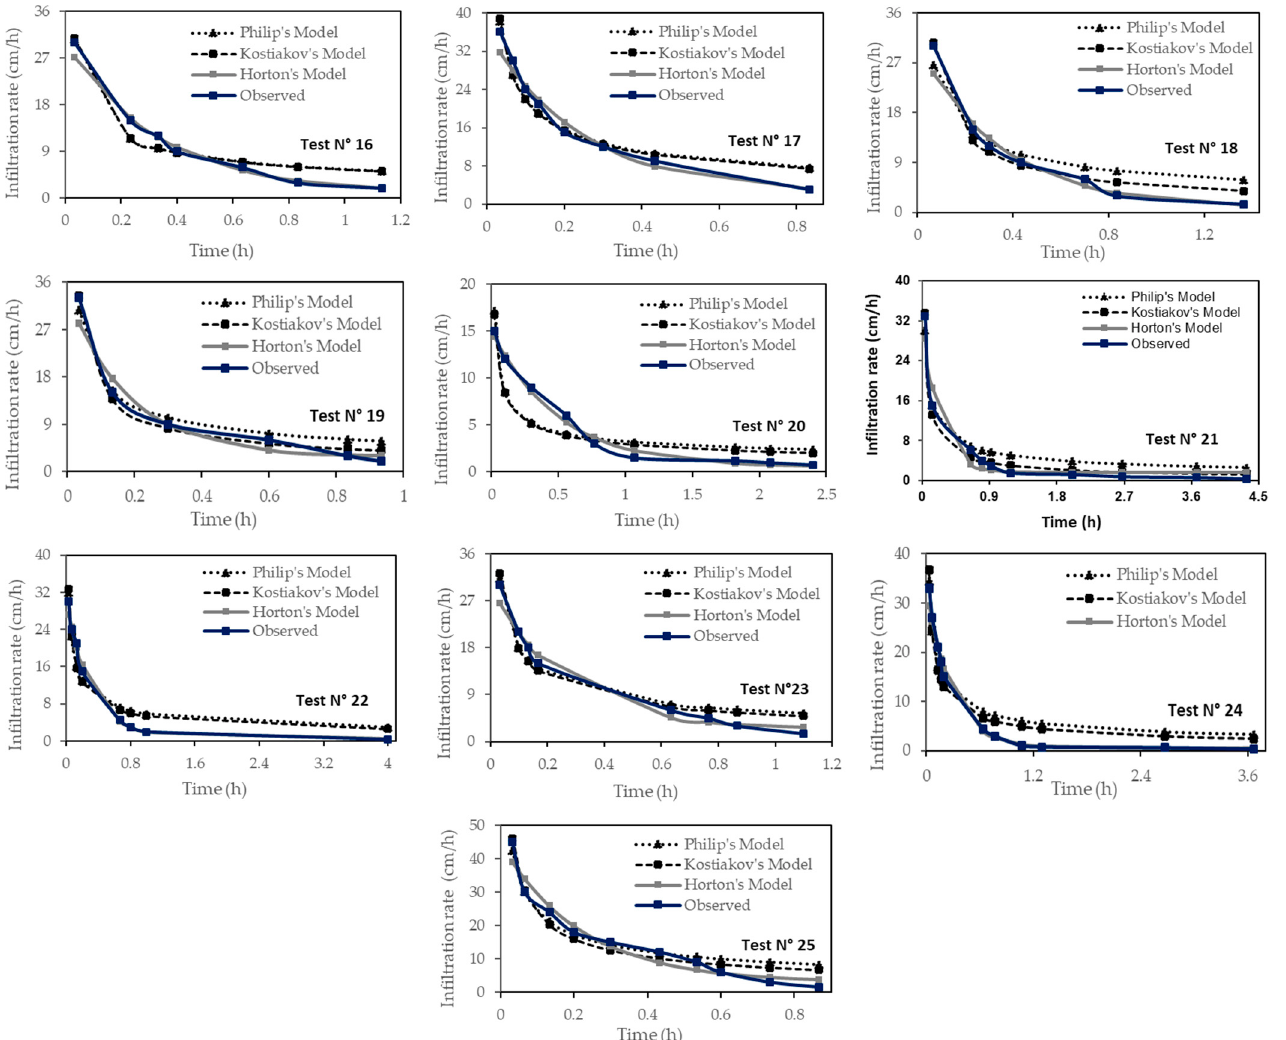
Figure 5. Inter-comparison of field infiltration rates from different models for Madjez Ressoul catchment.